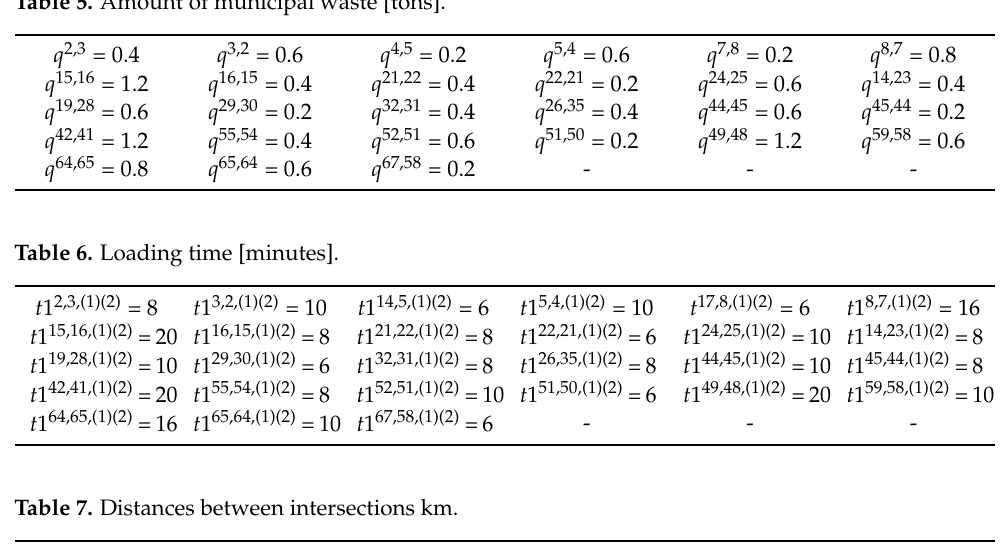
Table 5. Amount of municipal waste [tons].